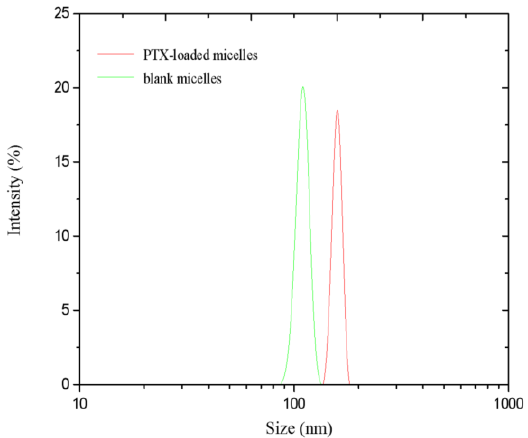
Figure 4. Size distributions of the blank micelles and paclitaxel (PTX)-loaded micelles.